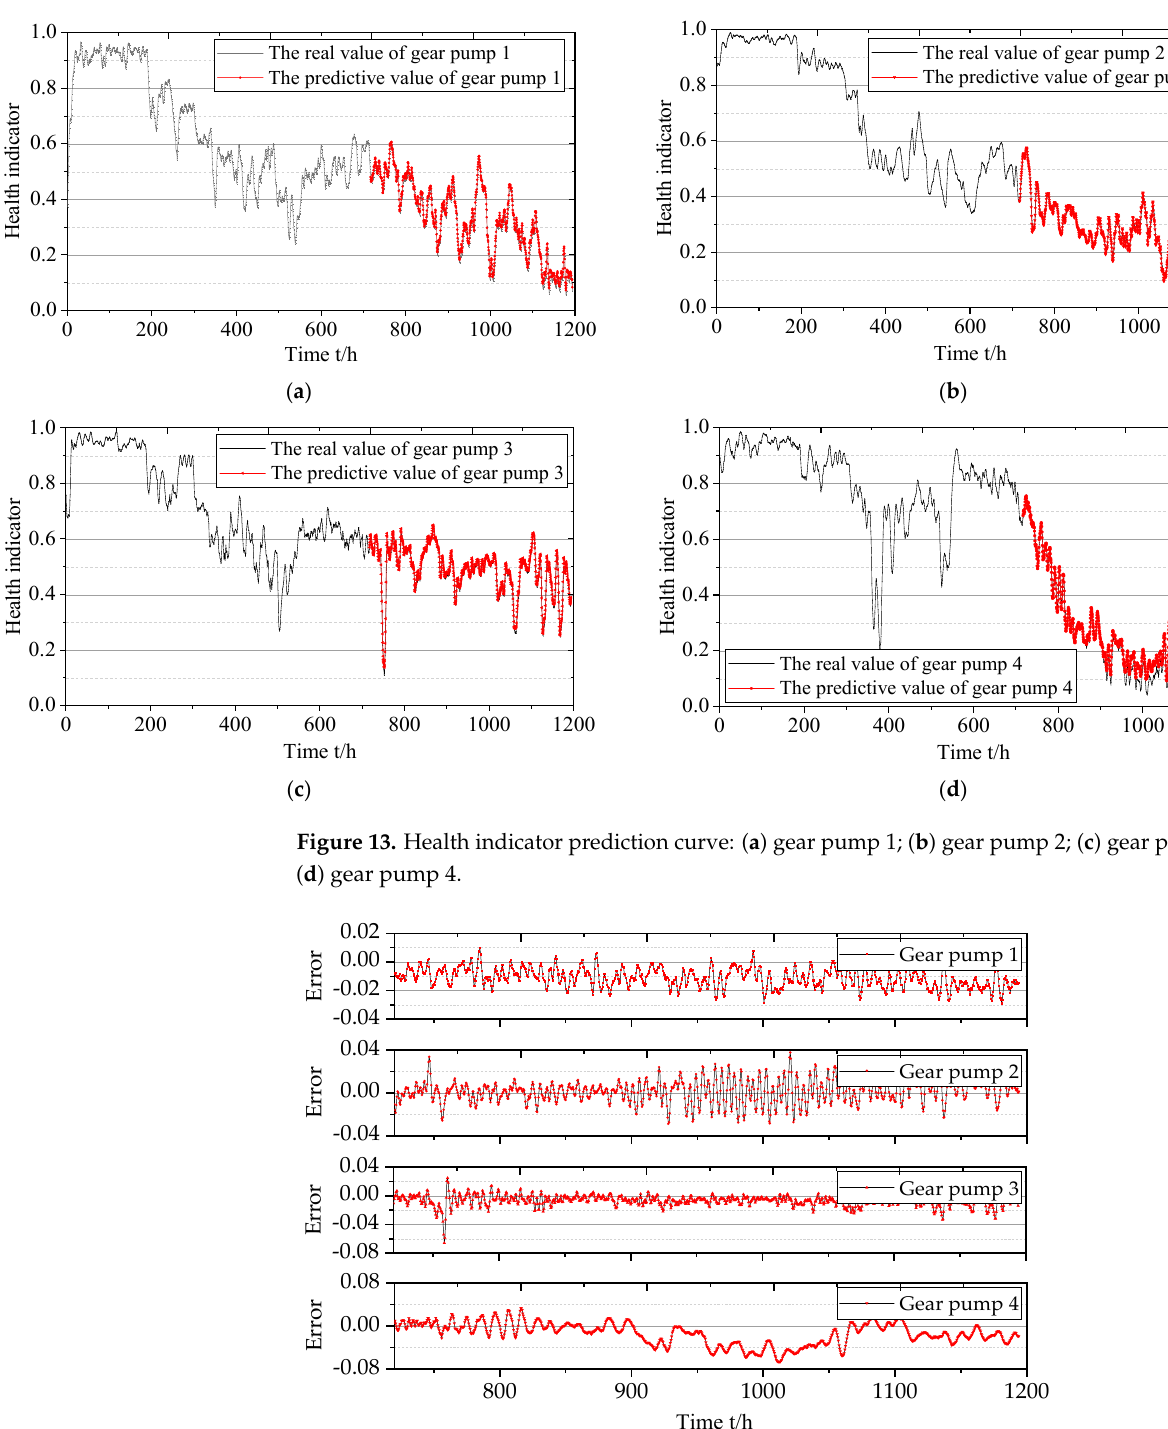
16 of 21 Table 5. Comparative analysis of three evaluation indexes of health indicators. Gear Pump Evaluation Indexes